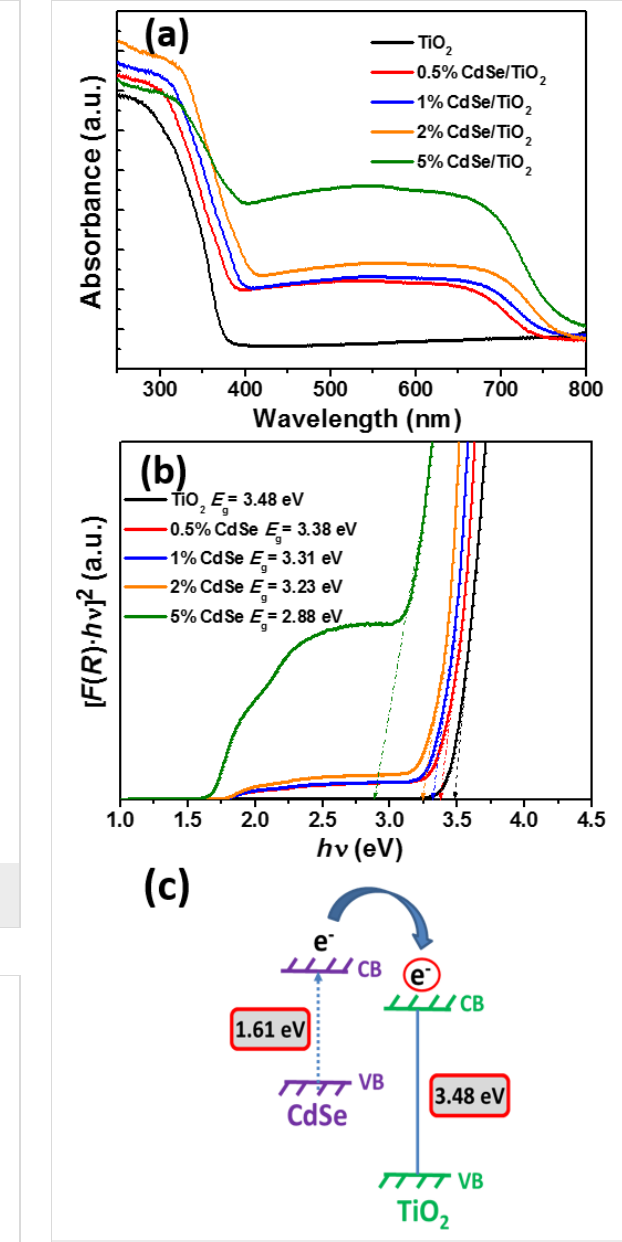
Figure 4: (a) UV–visible absorption spectra of TiO 2 and CdSe/TiO 2 composites, (b) plots of transformed Kubelka–Munk functions [ F ( R )· h ν ] 2 vs h ν for TiO 2 and CdSe/TiO 2 composites, and (c) energy level diagram for CdSe NRs/TiO 2 composites.